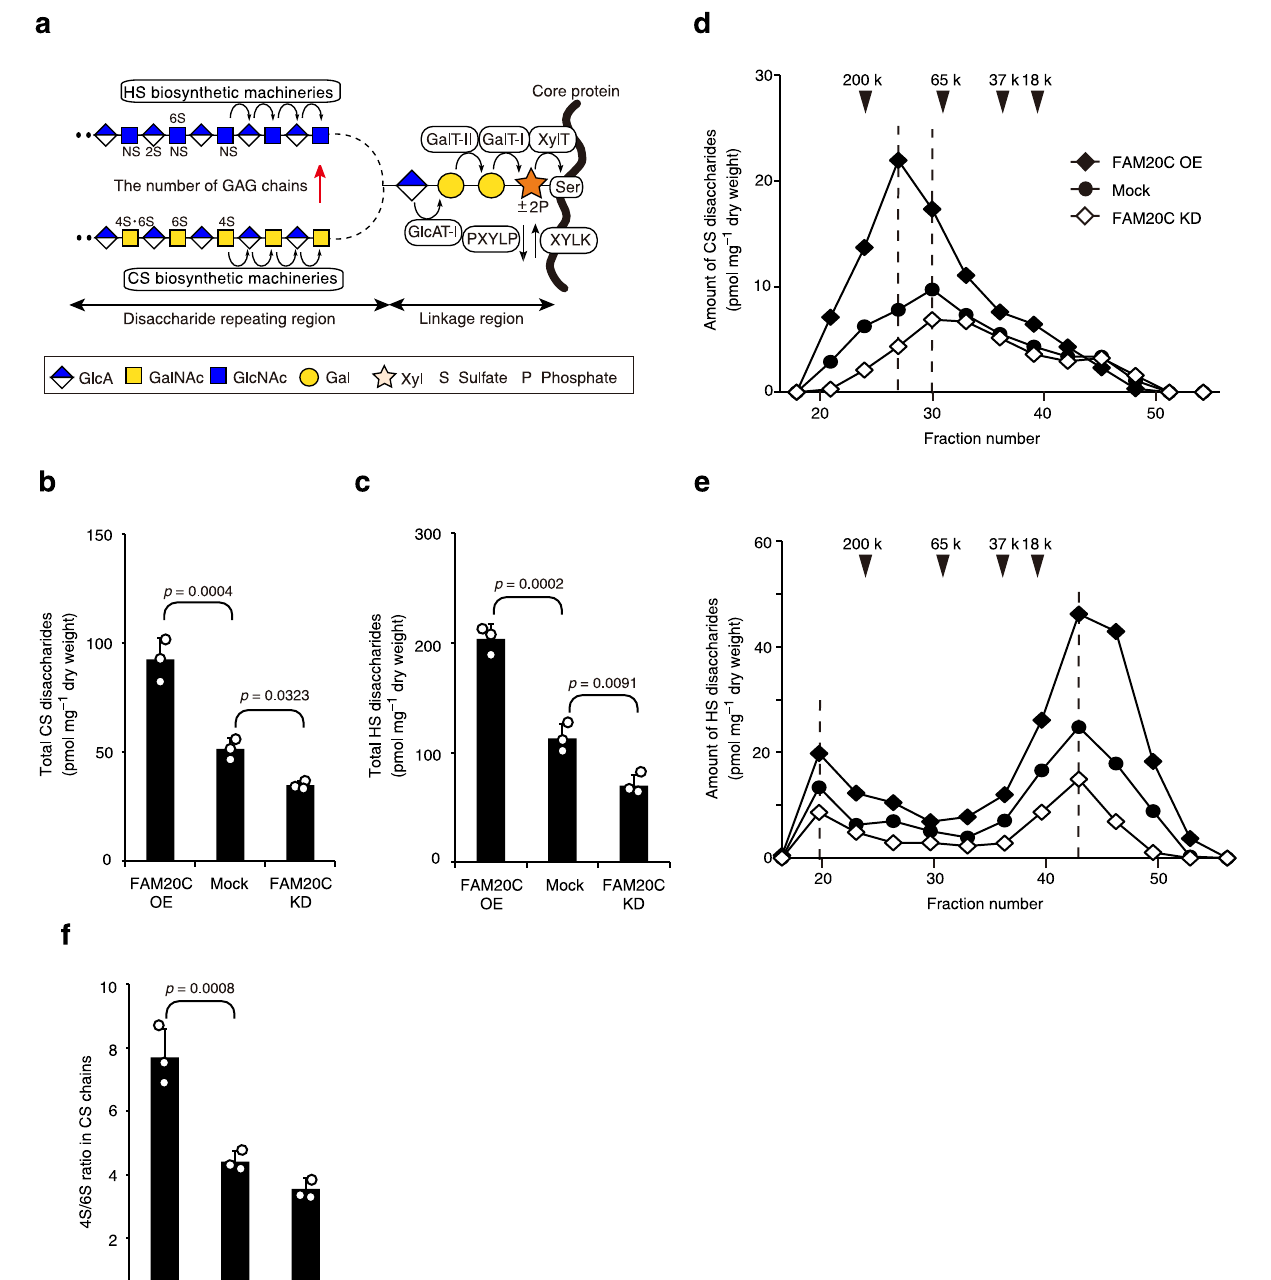
Fig.1|FAM20CcanregulateGAGabundance.a BiosyntheticpathwaysforCSand HS GAG chains. Multiple glycosyltransferases and distinct kinase/phosphatase(s) contribute to the synthesis of the common tetrasaccharide linkage region and repeating disaccharide region characteristic of CS and HS chains. Transient phos- phorylation of the Xyl residue by XYLKs, including FAM20B, enhances linkage tet- rasaccharide synthesis. Before subsequent GAG assembly by distinct biosynthetic machinery for CS and HS chains, the Xyl residue is dephosphorylated by a 2-phosphoxylose phosphatase (PXYLP). This XYLK-enhanced GAG biosynthesis determines the number of CS and HS chains attached to core proteins. XylT xylo- syltransferase, GalT-I β 1,4-galactosyltransferase-I, GalT-II β 1,3-galactosyltransferase- II, GlcAT-I β 1,3-glucuronyltransferase-I. b , c Constitutive overexpression (OE) of